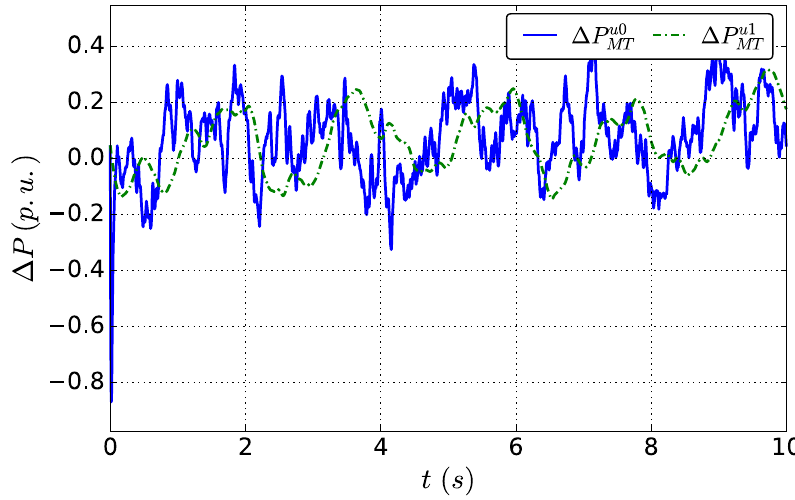
Figure 8. Power deviations of micro-turbines (MTs) under controllers u 0 and u 1 .